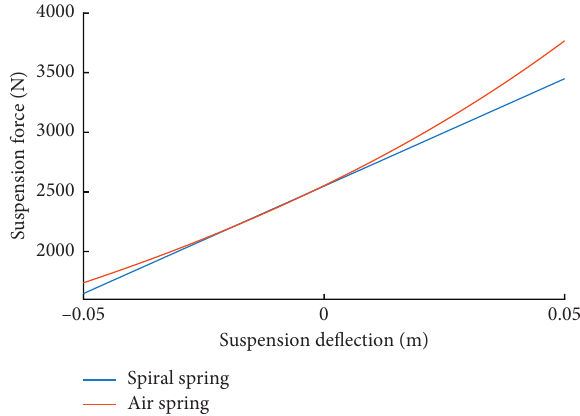
Figure 8: Comparison between air spring and spiral spring